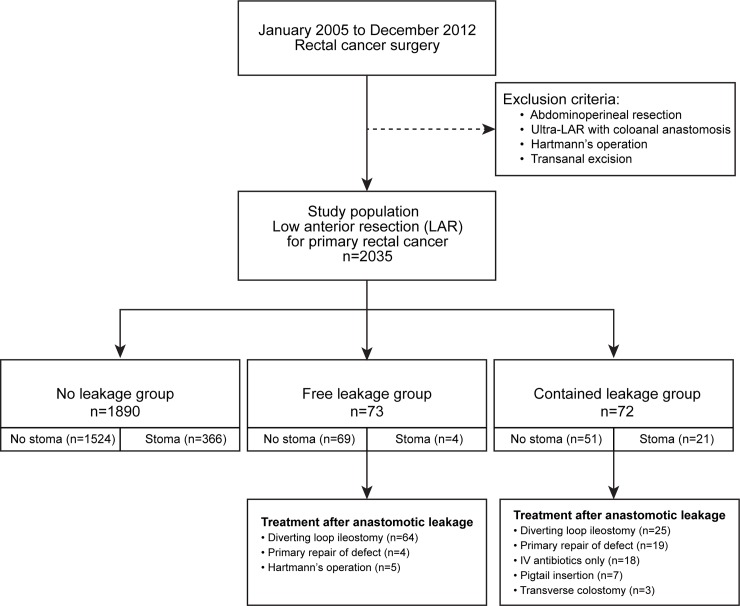
Flow chart of patient selection.LAR, Low anterior resection.